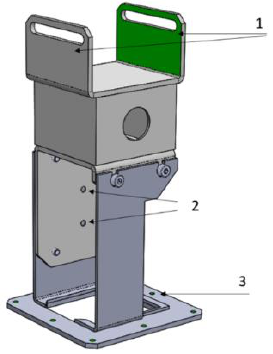
Figure 6. Component coupling surface.